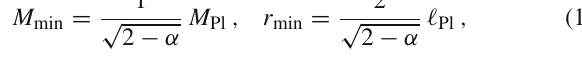
Beforeproceeding,itisusefultocompareEq.(11)withthe